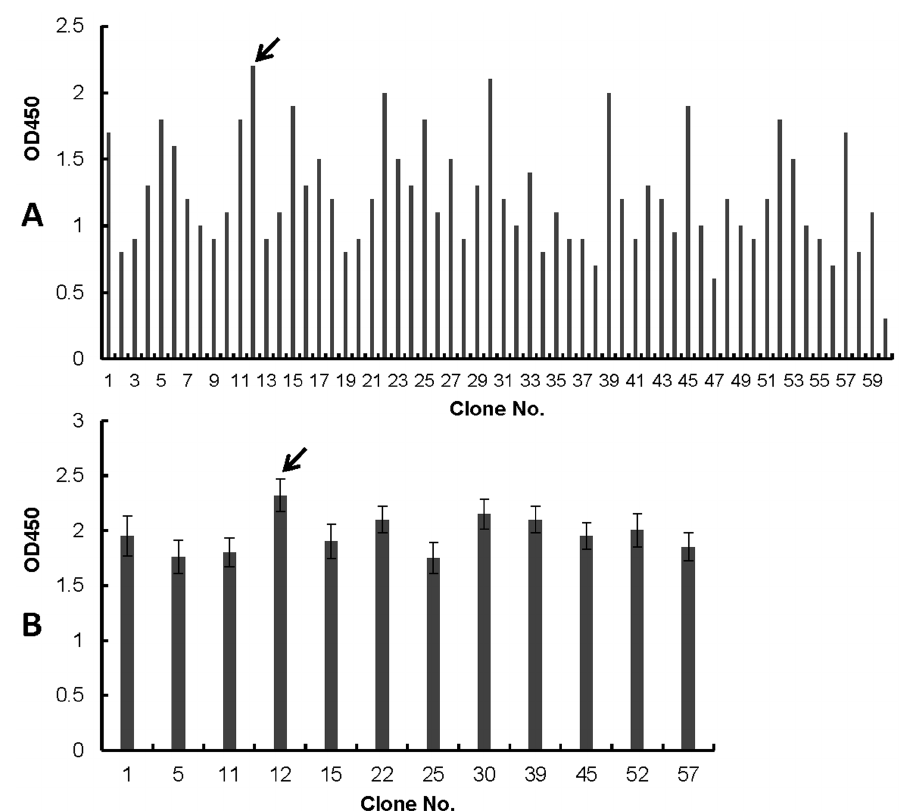
Figure 1. Selection and comparison of transfected cell clones expressing E2 protein using ELISA. E2 protein expressing titers were detected and compared between 60 G418-resistant and IFA-positive cell clones (A). Among the 60 cell clones, 12 cell clones with a relative high titer of E2 were selected and further compared using ELISA (B). The no. 12 cell clone, which had the highest ELISA titer value was selected for further characterization (as shown by the arrow).